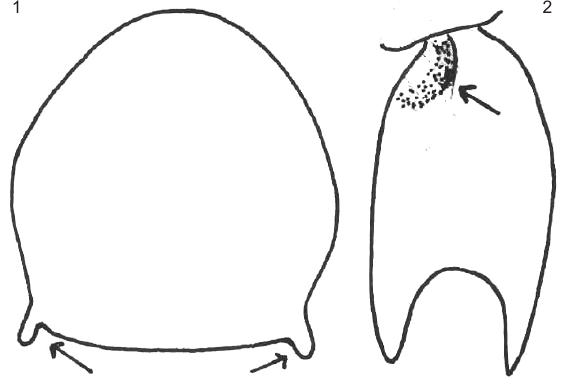
and the remaining abdominal segments yellow. Wings